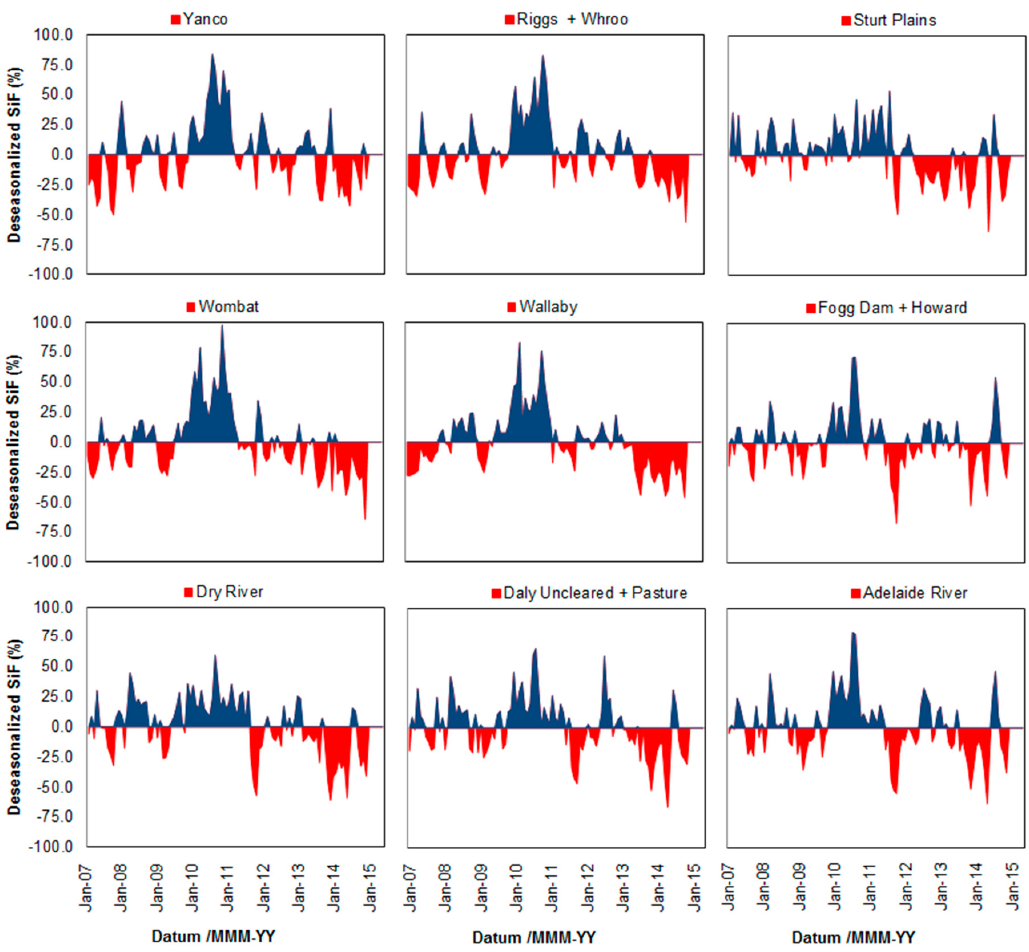
Figure 7. Observed Sun-induced Fluorescence (SiF) for the period January 2007 to June 2015 over Australian flux tower sites. SiF data are de-seasonalized. Positive anomalies are given in blue, negative anomalies in red. For some locations two sites with different biomes fall into the same GOME-2A SiF gridcell (Riggs + Whroo; Fogg Dam + Howard; Daly Uncleared + Pasture).